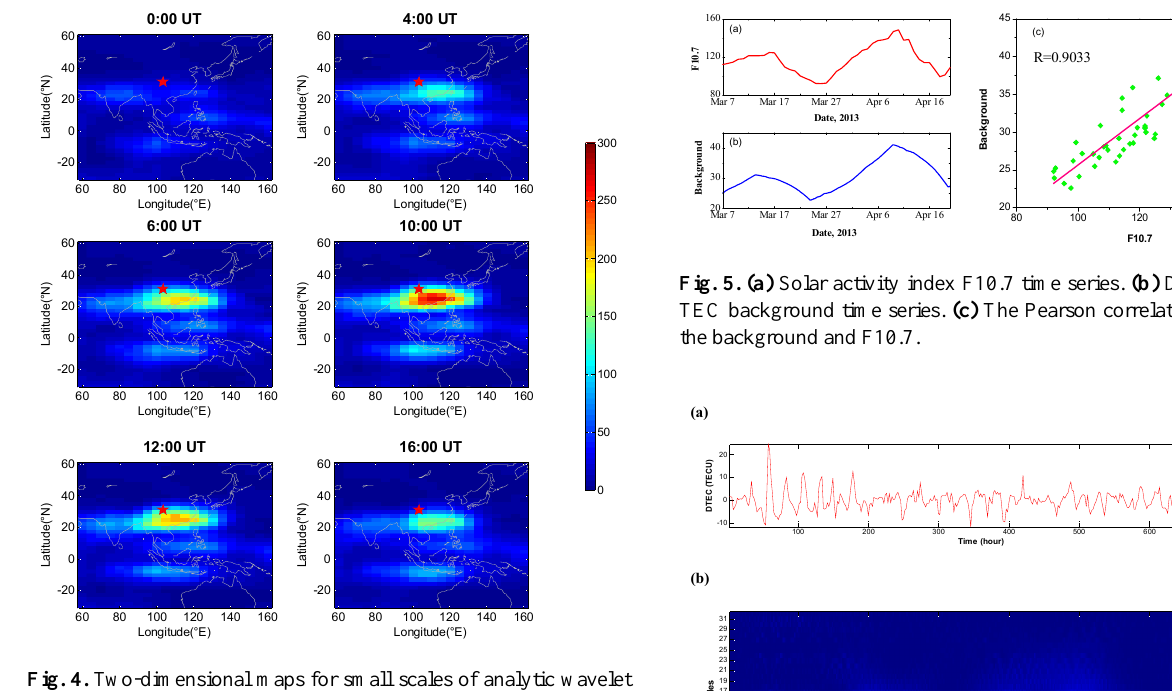
Fig. 4. Two-dimensional maps for small scales of analytic wavelet Figure 4. Two-dimensional maps for small scales of analytic wavelet energy density spectrum energy density spectrum on 9 May 2008 from 00:00 to 16:00UT. on 9 May 2008 from 00:00 to 16:00 UT, respectively. The red star represents the epicenter. The red star represents the epicenter.